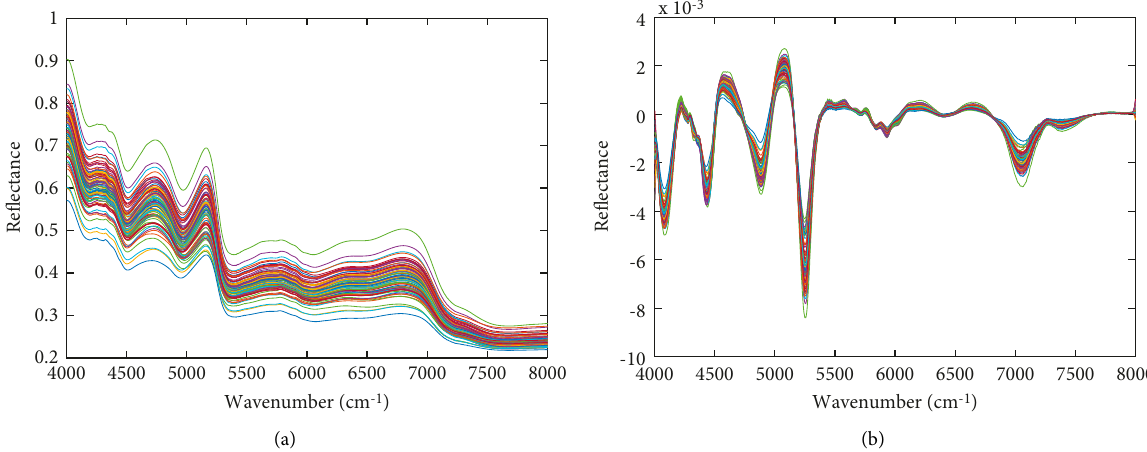
Figure 1: (a) Original and (b) preprocessed FT-NIR spectra of the samples. First derivative and Savitzky–Golay smoothing algorithms were chosen as preprocessing approaches.